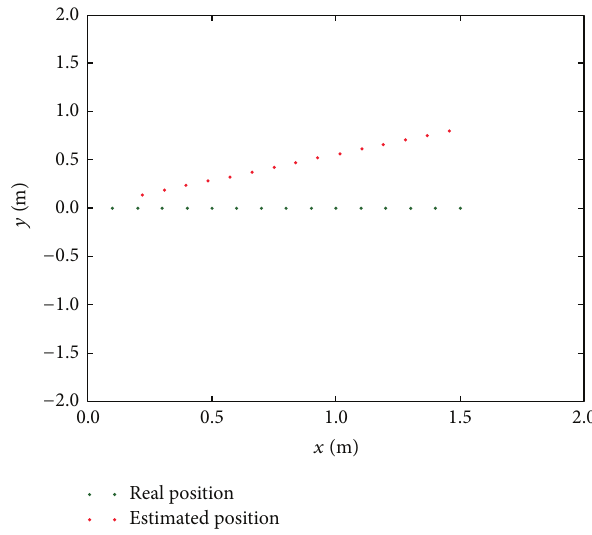
Figure 2: The experiment motion results of robot without closed- loop controller.